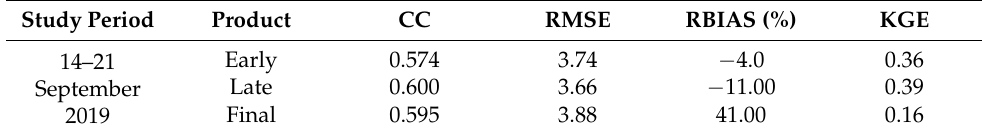
Table 2. The areal average of the basic statistical indices of the satellite products.